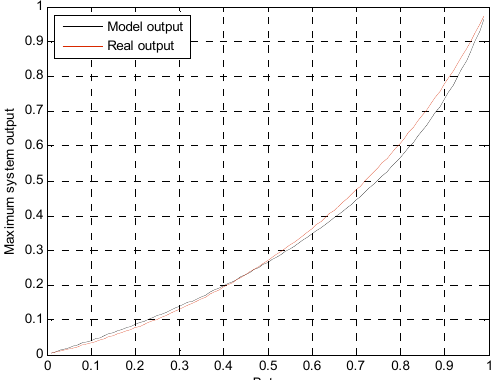
Figure 7. Comparison graph of PVVE output for the mathematical model and simulated real output.